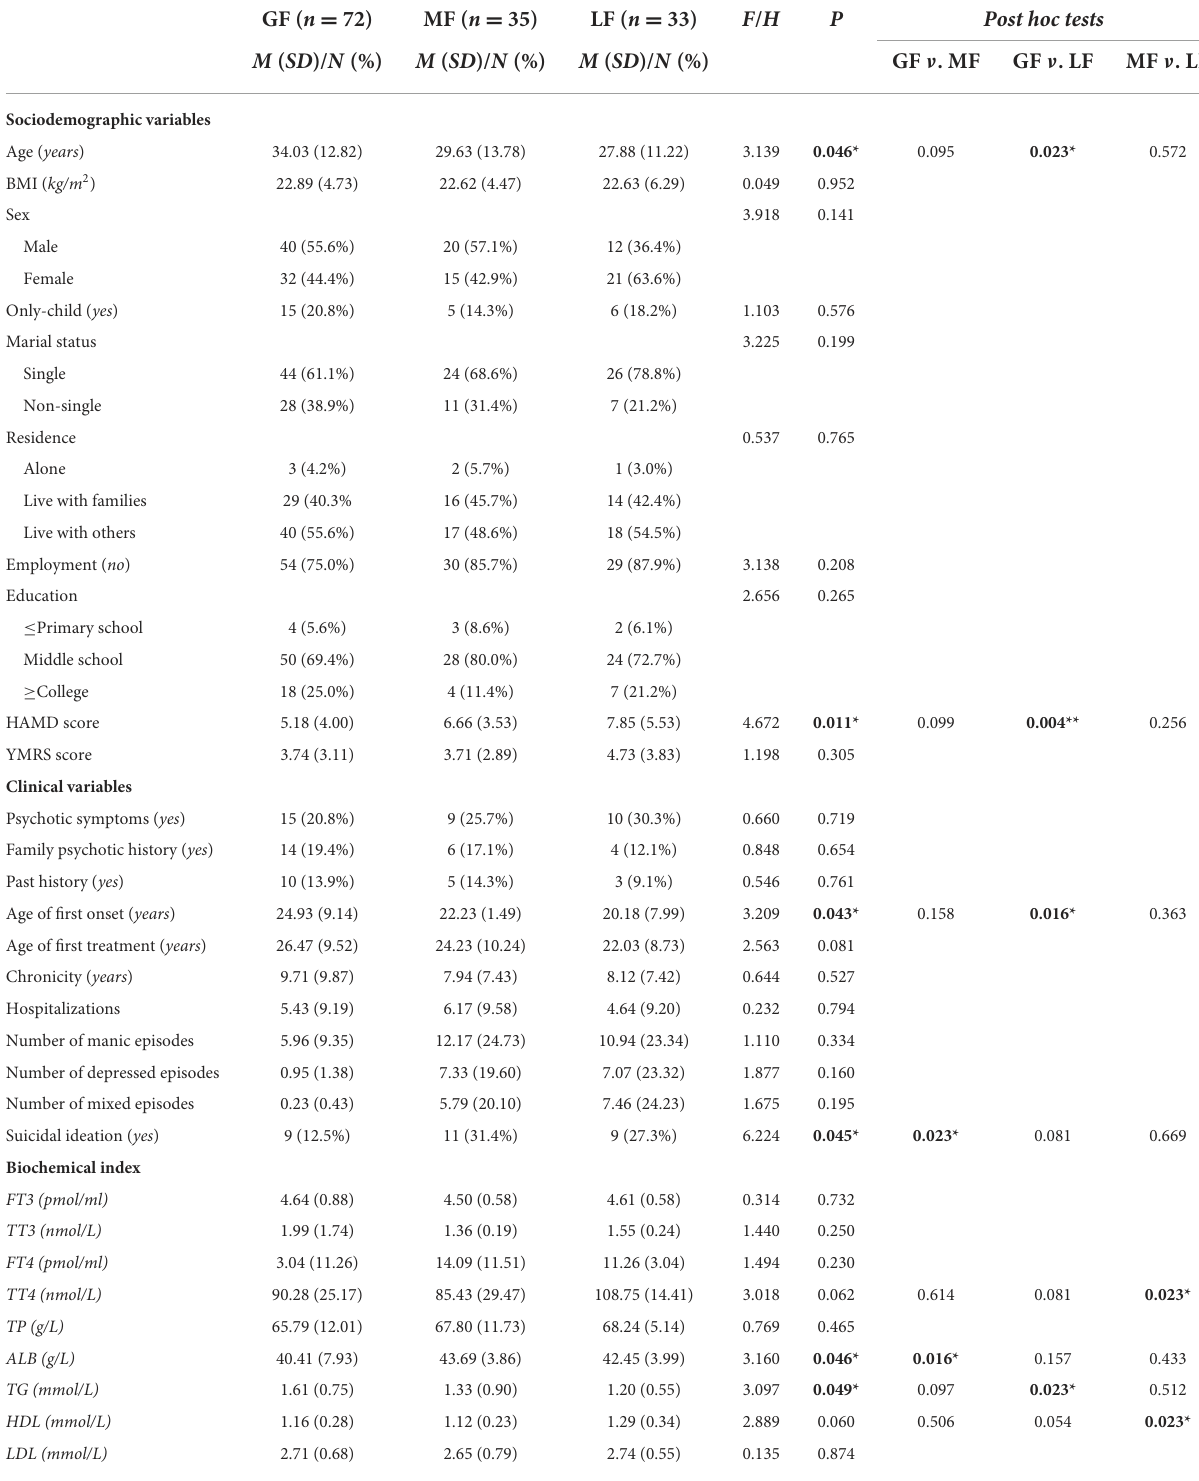
TABLE 3 Comparisons in sociodemographic, clinical and biochemical variables between the three functional